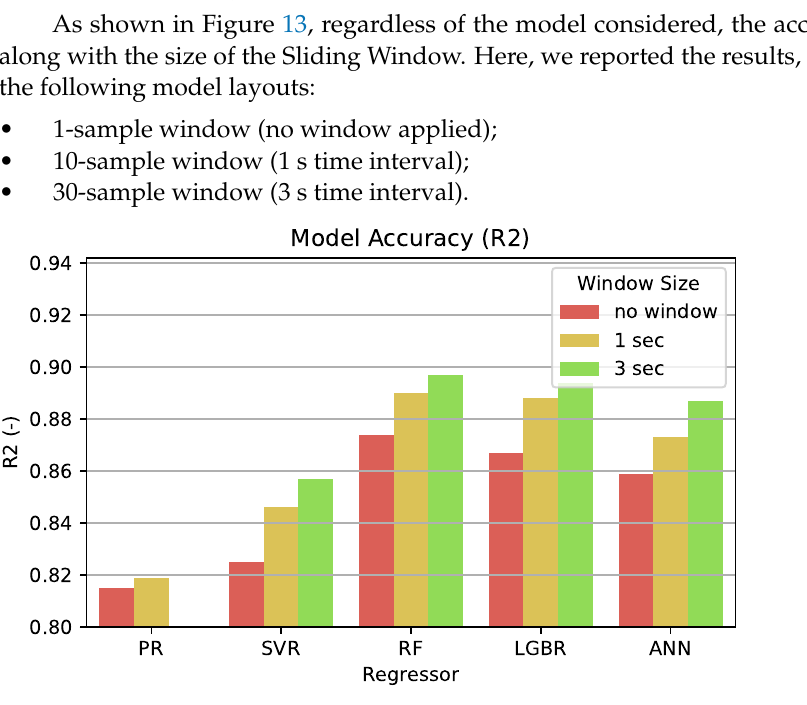
Figure 13. Comparison of the accuracy (represented by R2) of different data-driven models depending on Sliding Window